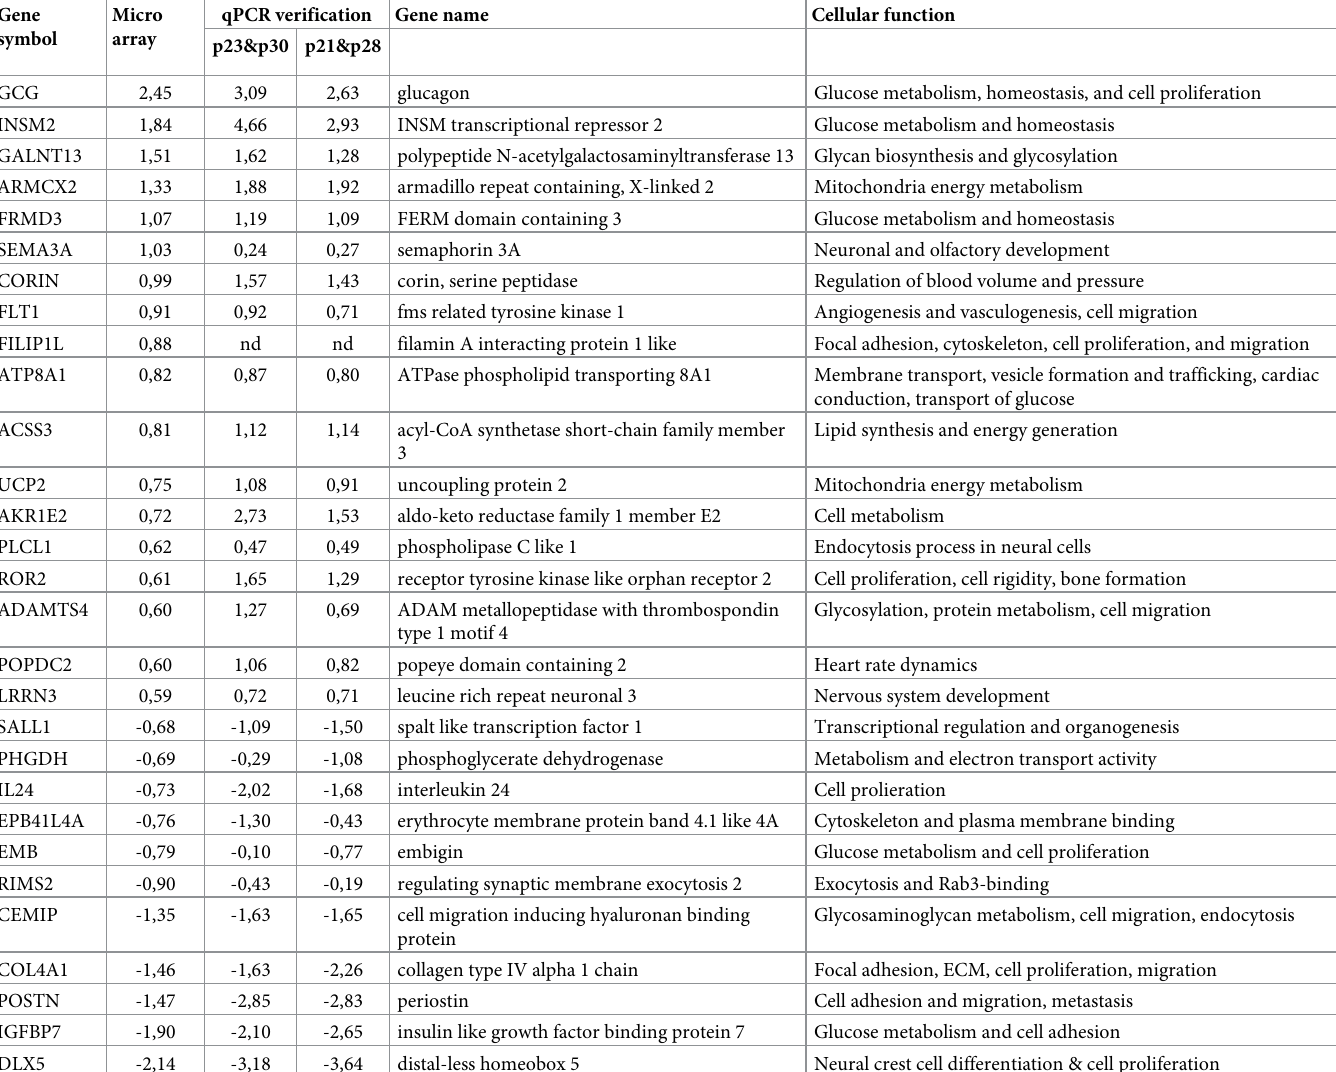
Table 2. Differentially expressed genes in MYO5B-mutants. Gene Micro symbol